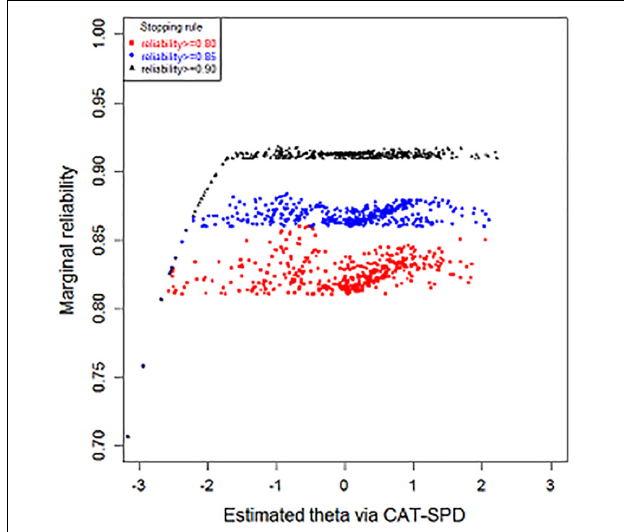
FIGURE 4 | Reliability as a function of the theta under different stopping rules.